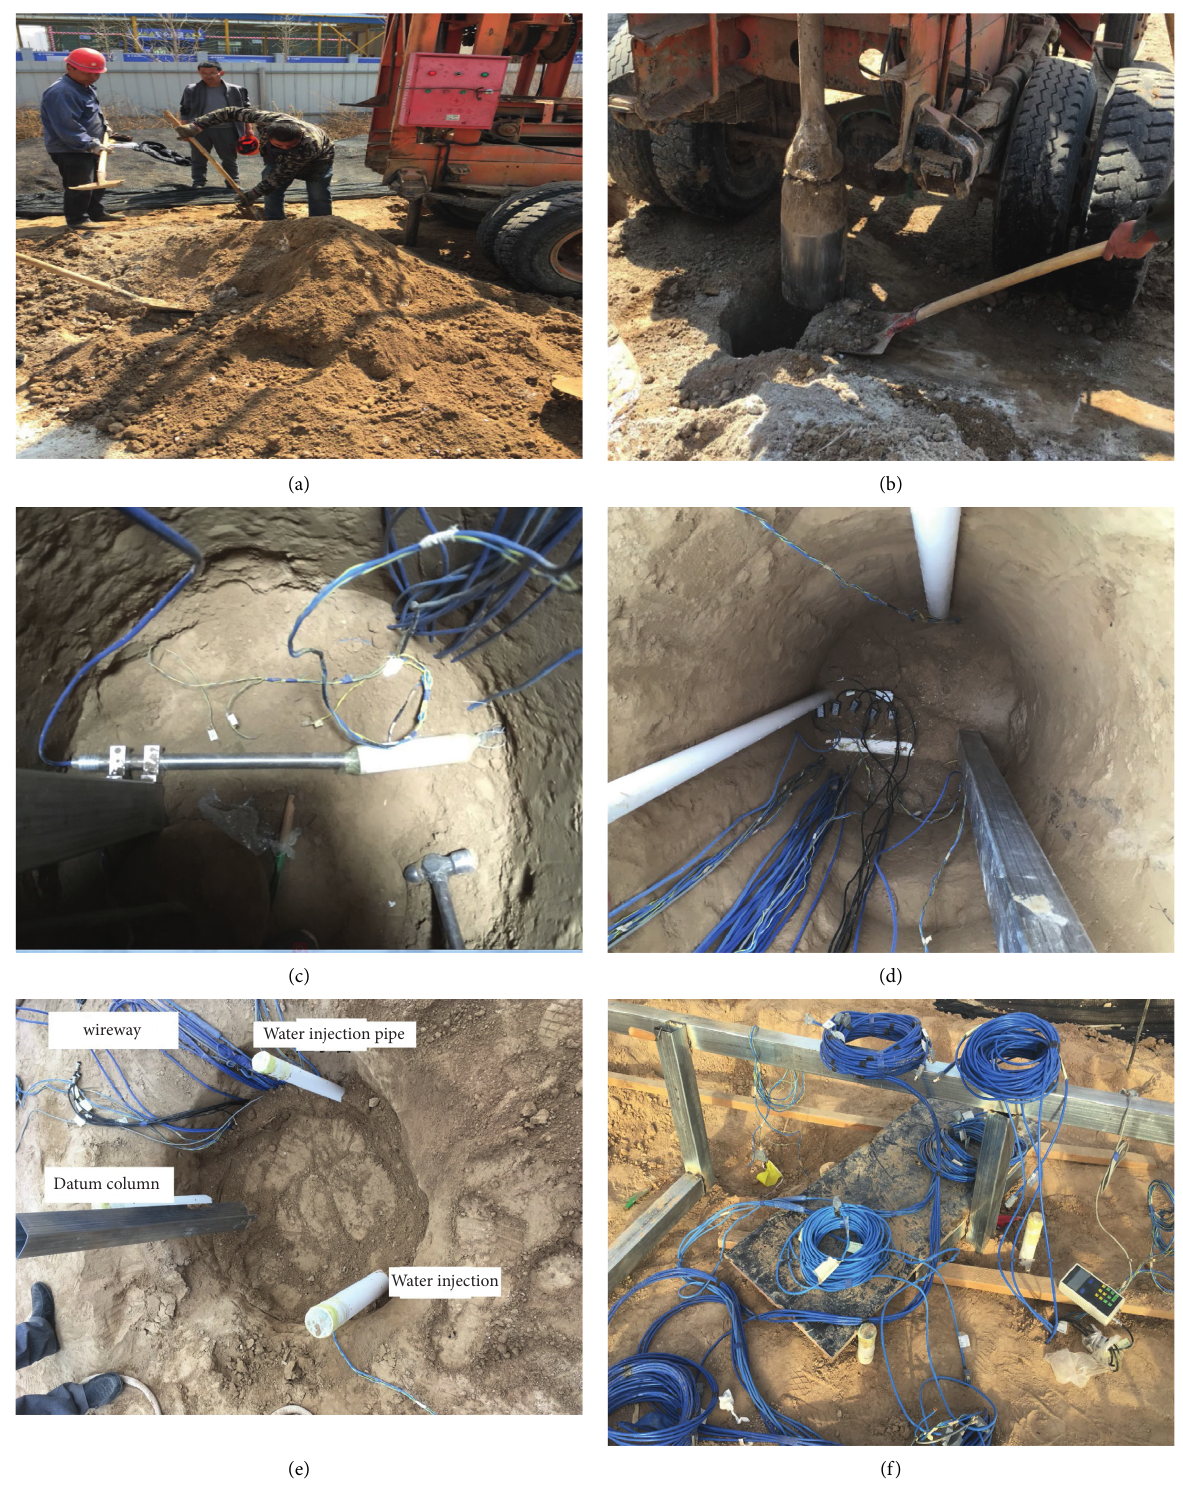
Figure 1: The field test. (a) Mixing lime soil. (b) Lime soil by using the hammer. (c) Sensor in the hole. (d) Sensor layout. (e) Layout plan of the pile top. (f) Test site after